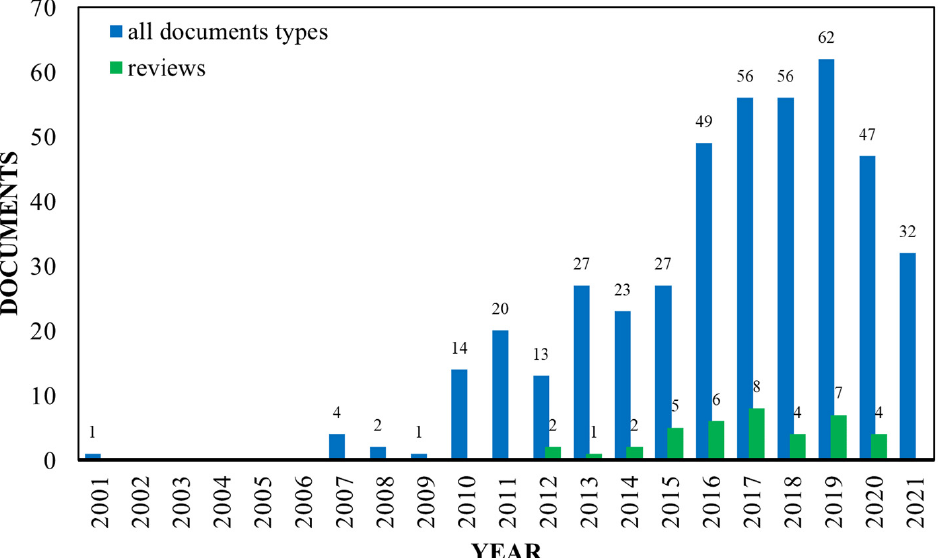
Figure 1. Bibliometric trends for jet biofuel research. Search algorithms on Scopus: (TITLE-ABS-KEY (biojet AND fuel) OR TITLE-ABS-KEY (bio-jet AND fuel) OR TITLE-ABS-KEY (biokerosene)) and (TITLE-ABS-KEY (biojet AND fuel) OR TITLE-ABS-KEY (bio-jet AND fuel) OR TITLE-ABS-KEY (biokerosene)) AND (LIMIT-TO (DOCTYPE “re”)). According to the authors bibliographic research,